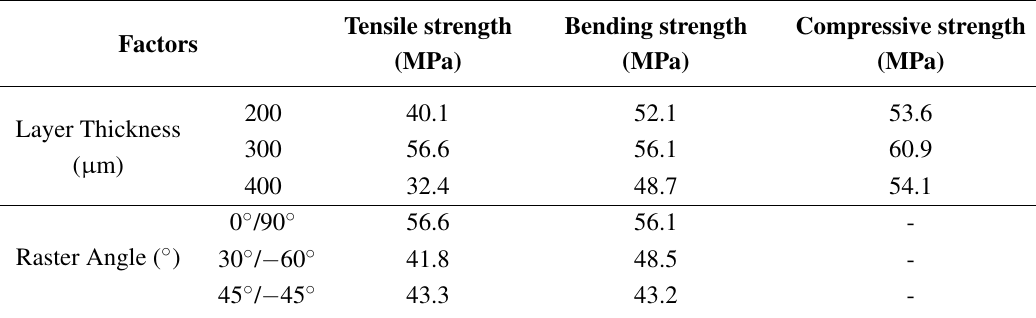
Table 3. Mechanical properties in different layer thickness and different raster